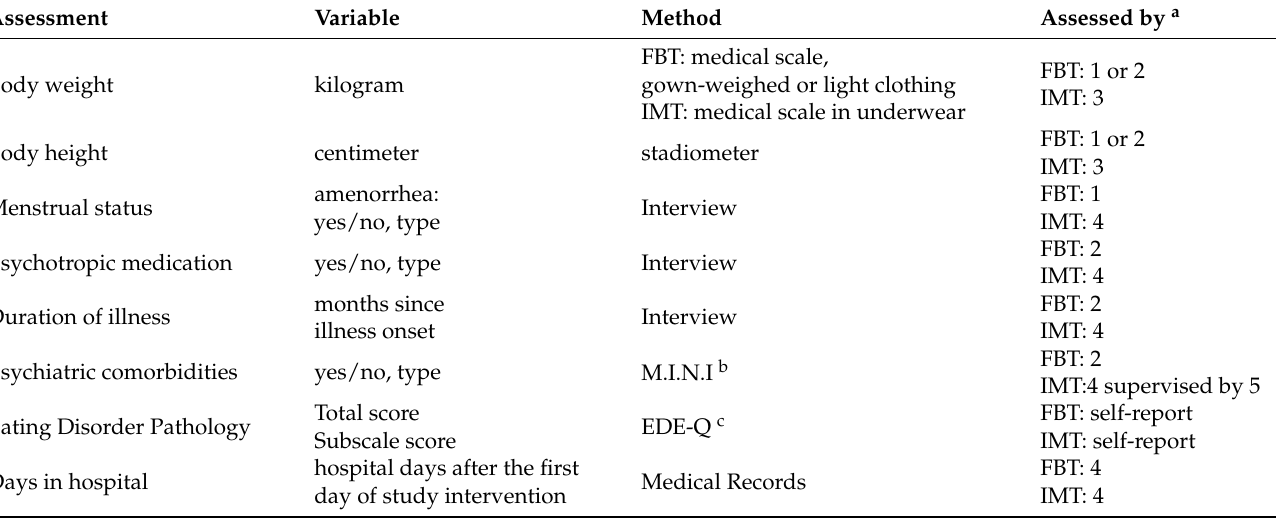
Table 2. Methodological overview of study assessments including clinical characteristics, psychiatric comorbidities, eating disorder psychopathology, and primary